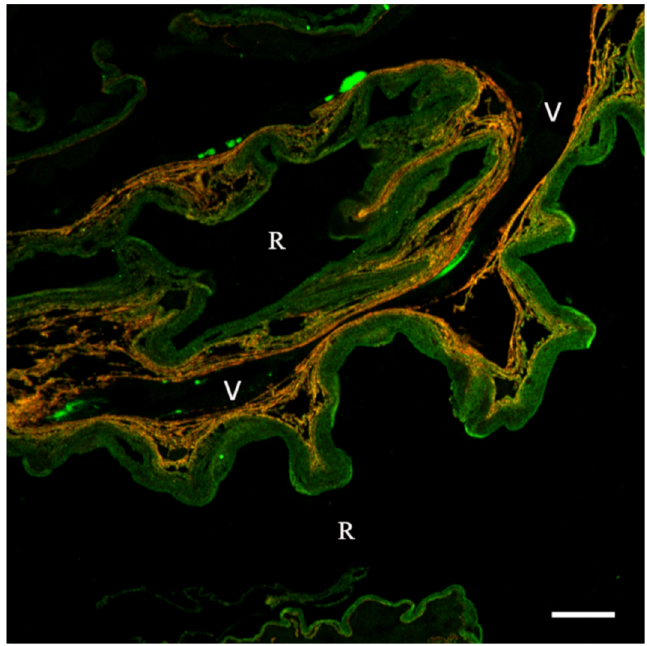
Figure 2. The iERM lamellar pattern of the ECM as a contributing factor to the tractional properties of the membranes. Confocal microscopy of an iERM detached from the ILM and labelled with anti-collagen I (green) and anti-collagen IV (red) antibodies. The vitreal (V) and retinal (R) sides of the membrane are indicated. The retinal side of the membrane is exclusively collagen I-immunoreactive, whereas the vitreal side is double labelled. Short strands of double-labelled matrix on the vitreal side of the membrane bridges the extremities of longer segments of the retinal side of the membrane. As a result, the membrane appears producing foldings that can be transferred on the underlying retina if the membrane is adherent enough to the inner limiting membrane. Magnification bar = 20 µ